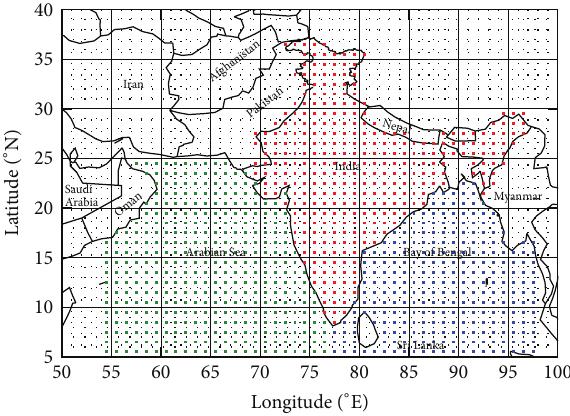
Figure 1: Map showing the study regions (in lat.-lon. grids) of Arabian Sea, India, and the Bay of